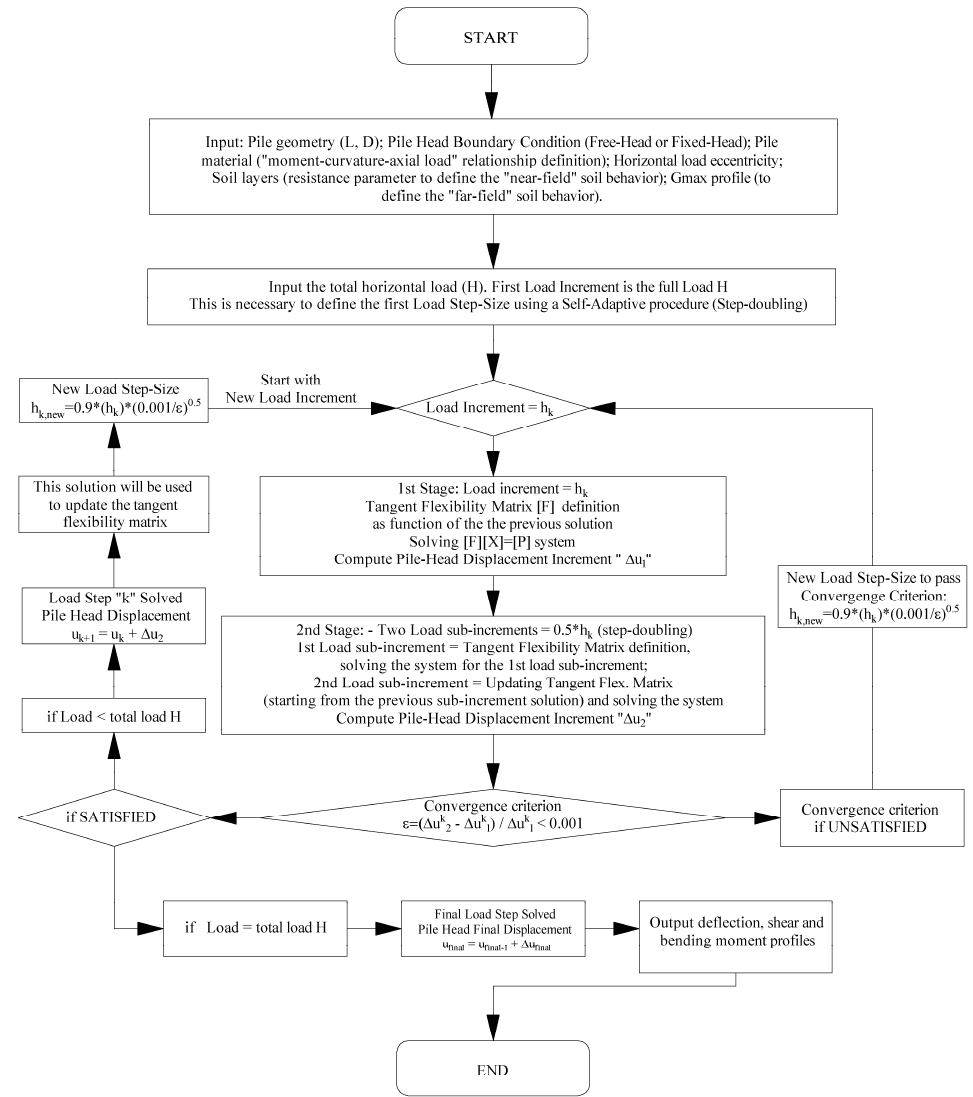
Figure 6. Flow chart of the proposed solution procedure.